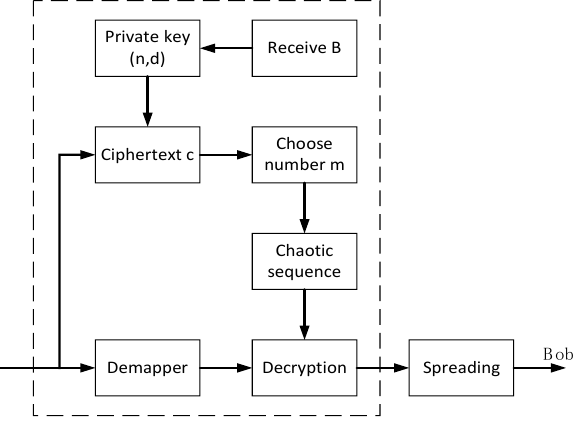
Figure 5. Block diagram of receiver